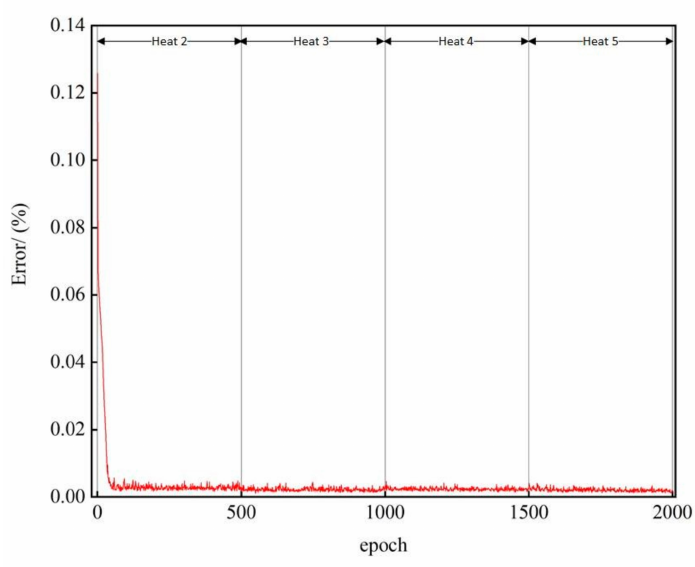
Figure 11. Training error curve of each model.